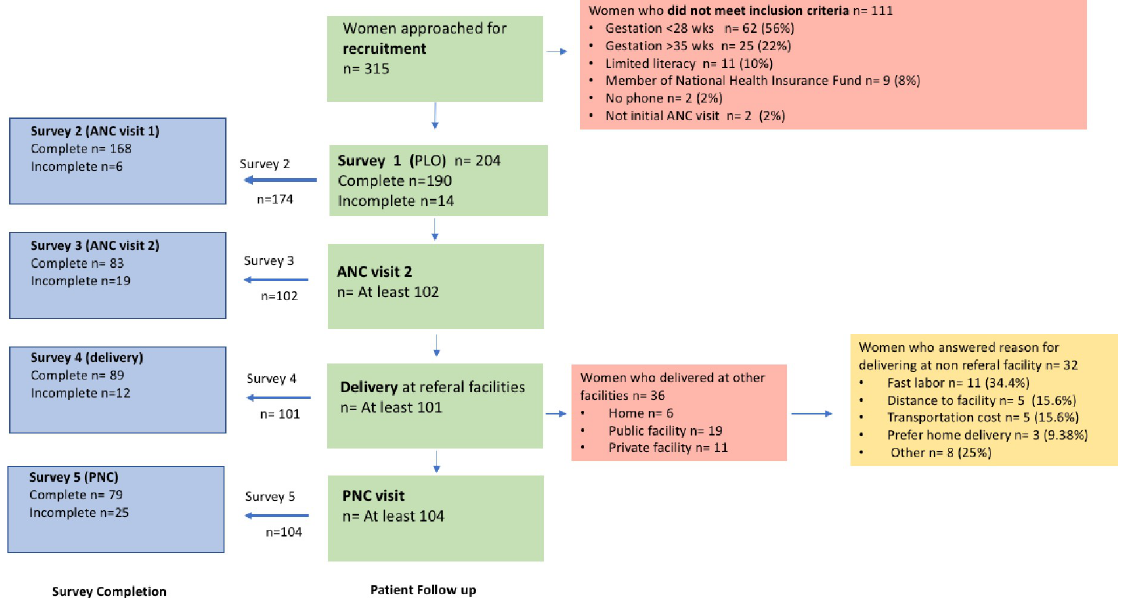
Fig 4. Flow of patients throughout pregnancy and